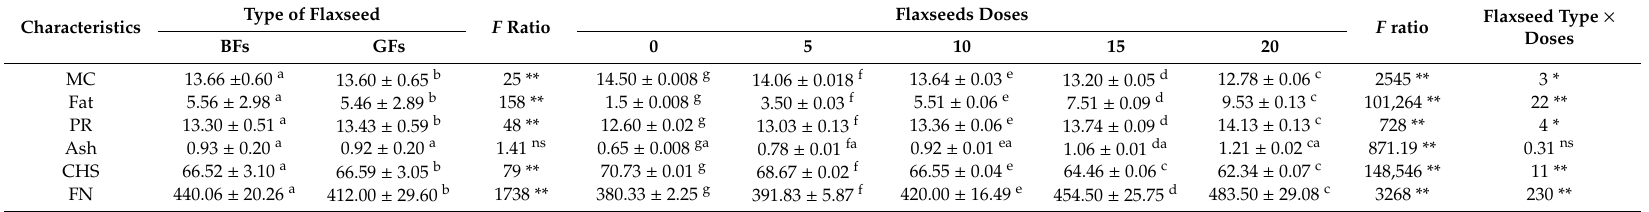
Table 4. The analysis of the variance of brown (BFs) and golden (GFs) flaxseeds addition to the medium quality flour for bread-making.